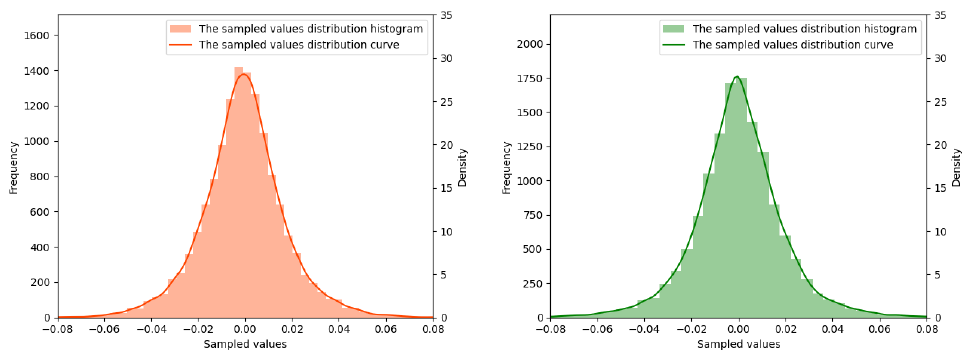
Figure 6. The sample value distribution comparison. On the left is the distribution curve and histogram of the sample values in the real audios, where the x -axis represents random variables, the left y -axis represents the frequency, and the right y -axis represents the density which is calculated as multiplying the frequency by the group distance. The same is true on the right for the stego-audios.